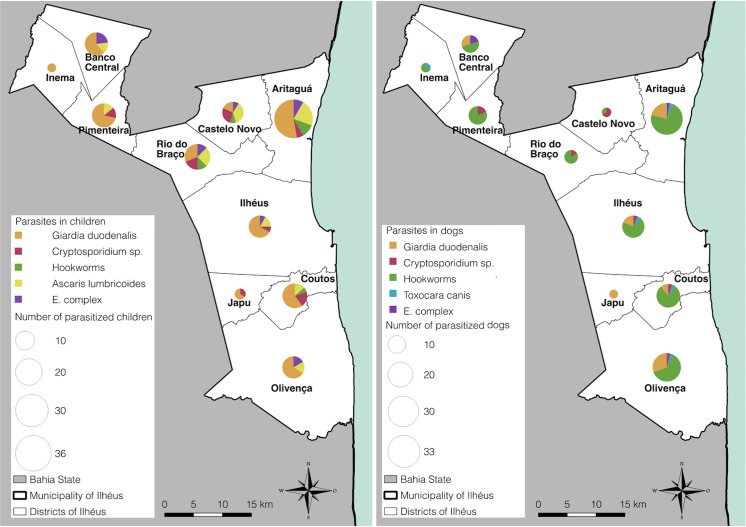
Overlapping enteric parasitic infections in the Municipality of Ilhéus at the district level.March to November/2016. This figure was prepared by using QGIS program (version 2.18).